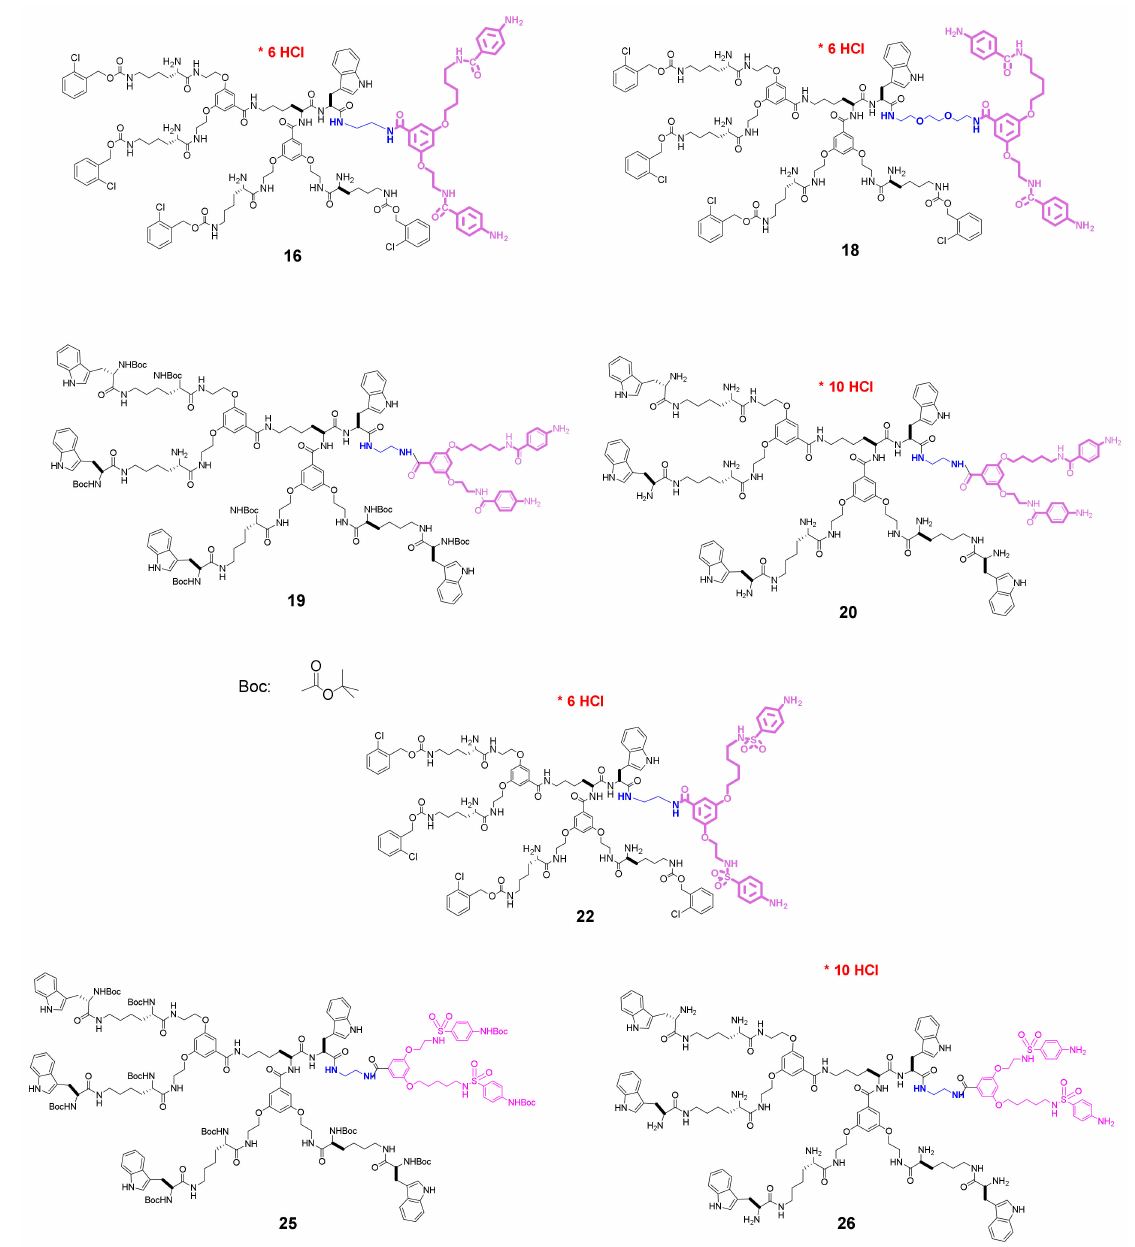
Figure 2. Chemical structure of the representative